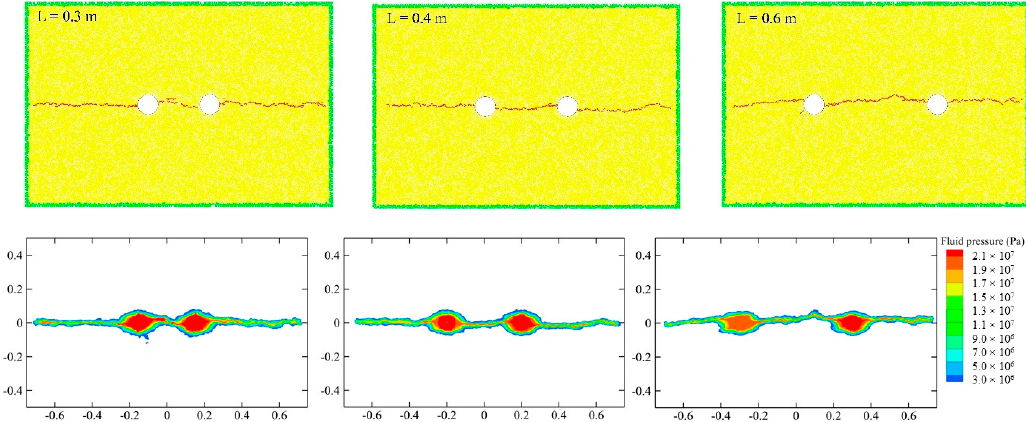
Figure 16. The crack spatial distributions and corresponding fluid pressure fields for the two-well granite models with the well spacing of 0.3 m, 0.4 m and 0.6 m in the simultaneous fracturing under the in-situ differential stress condition ( σ v = 15 MPa and σ h = 30 MPa).